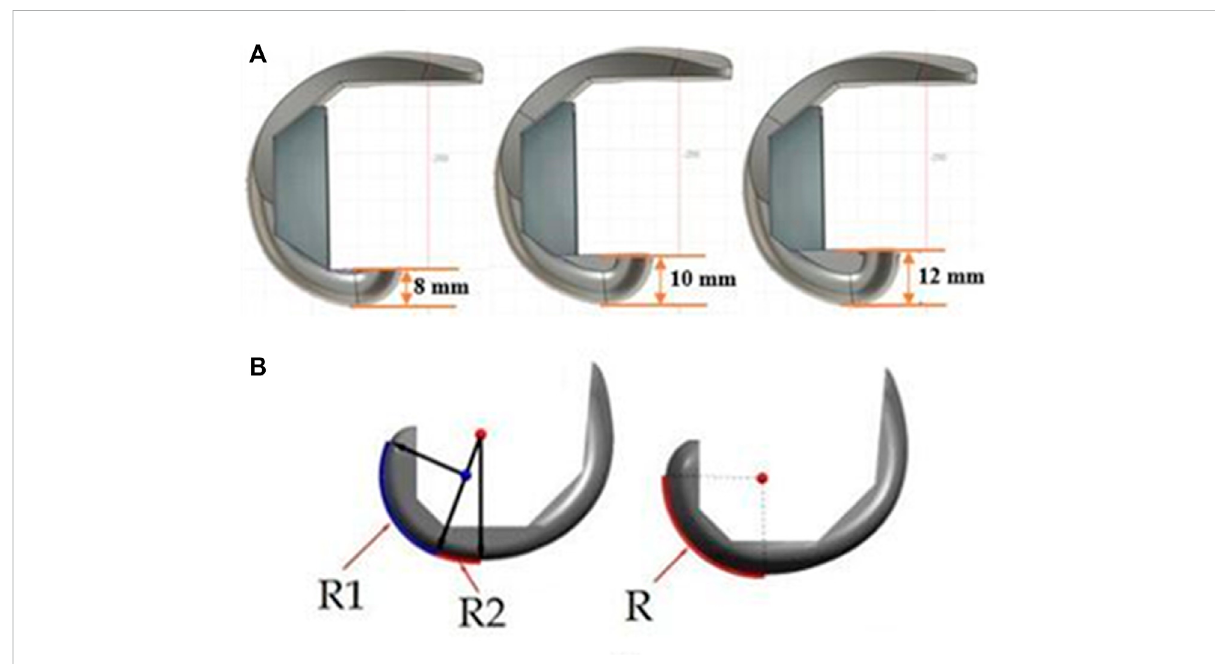
FIGURE 4 Development of femoral components AKJ, (A) C hange of PFC (Darmanto et al., 2022a), (B) Change of radius system (Fekete,